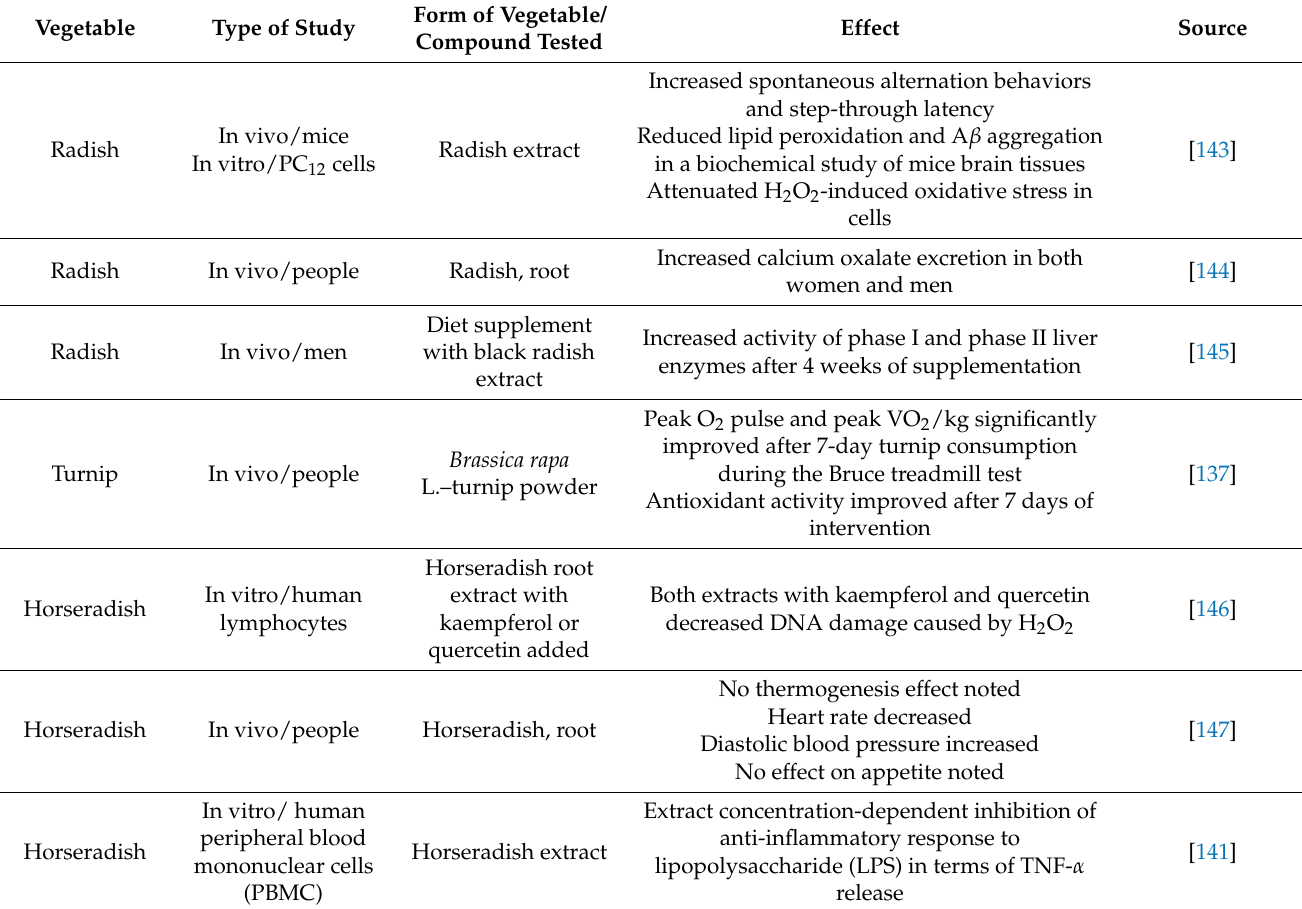
Table 6. Influence of root vegetables from the botanical order Brassicaceae on